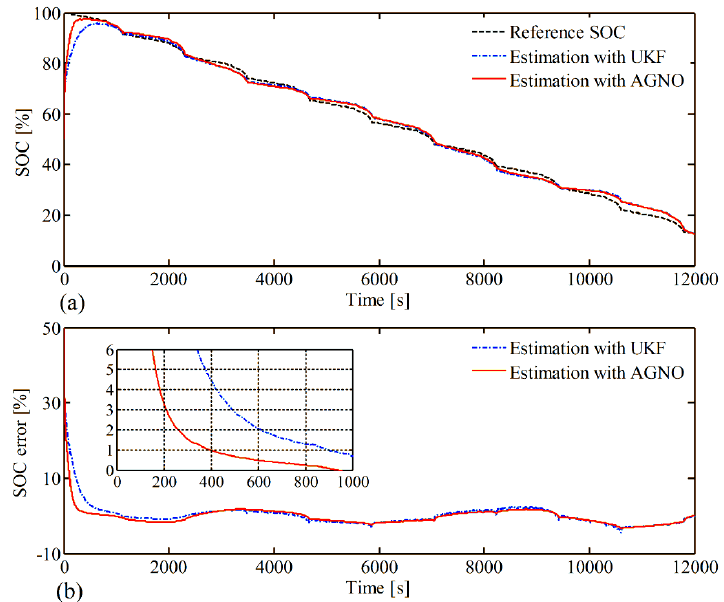
Figure 11. Comparison of convergence rate under NEDC test: ( a ) SOC ; and ( b ) SOC